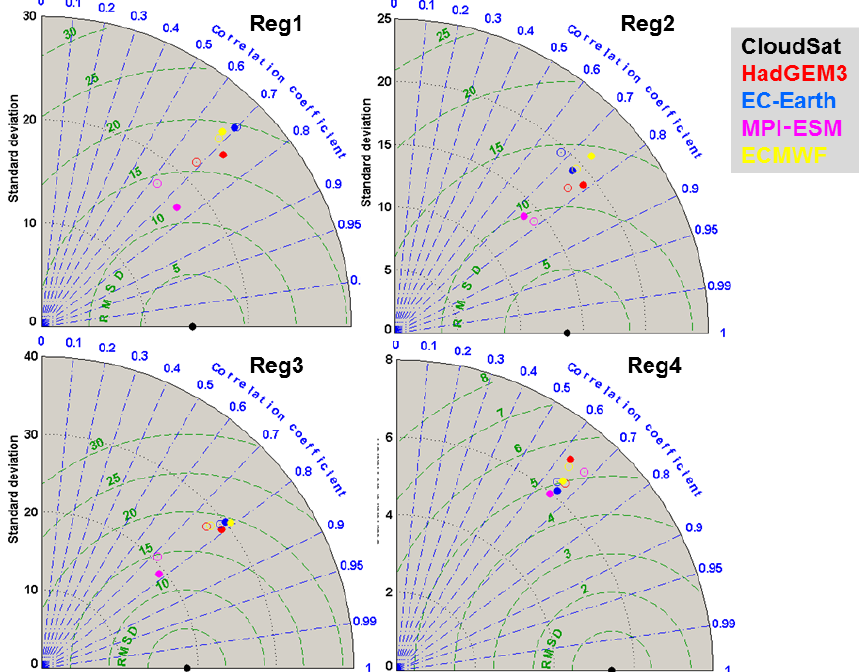
Figure 8. Taylor diagram of snowfall accumulation over the four regions from both Hi-res and Std-res models with respect to CloudSat observations. The empty circles denote the Std-res version of the models and the filled circles denote their Hi-res